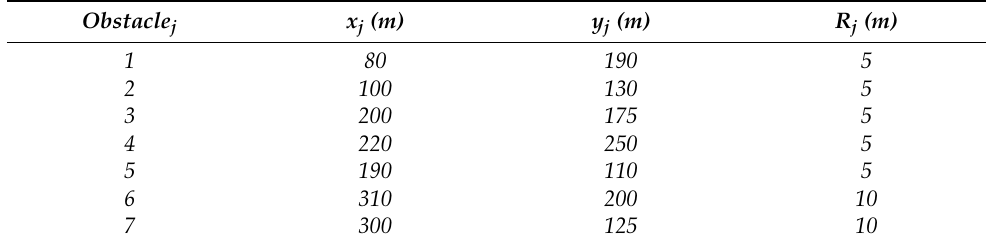
Table 8. Position and radius parameters of seven